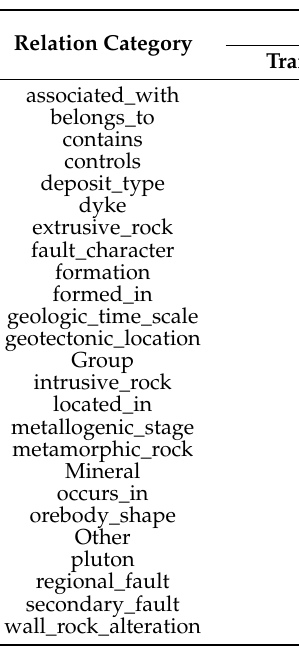
Table 5. The relation types for the geological